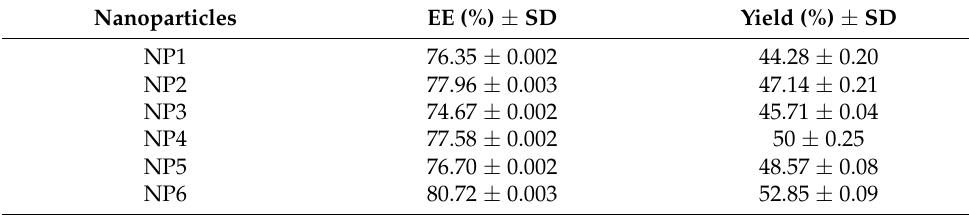
Table 5. Entrapment efficiency (EE) (%) and yield (%) of different formulations.